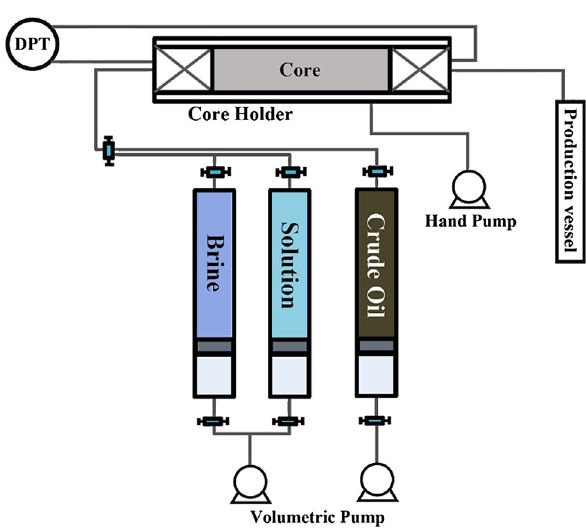
Fig. 1 Schematic image of the core flooding setup